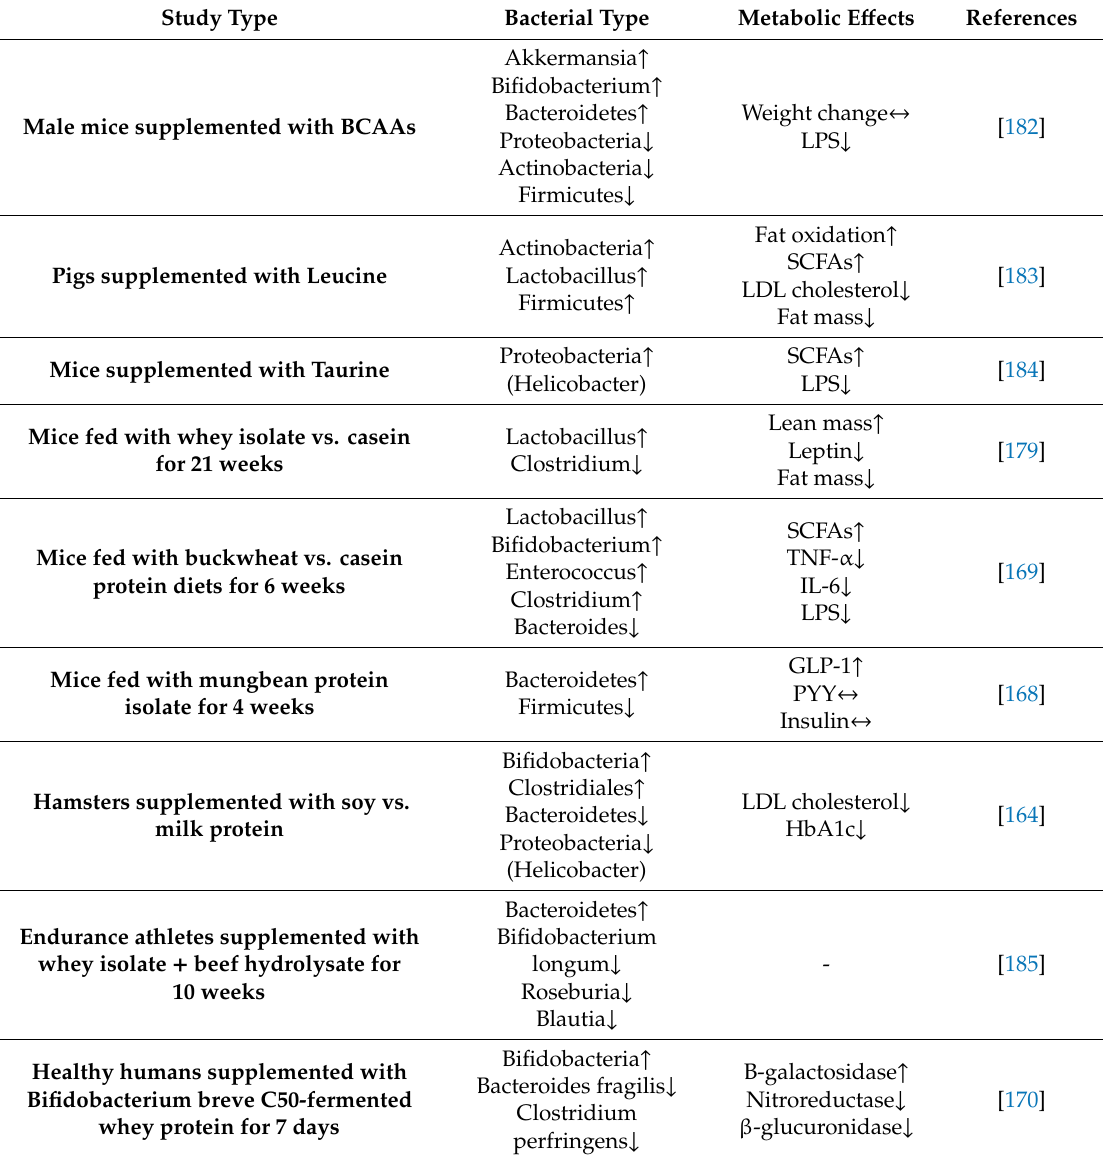
Table 1. Metabolic e ff ects of protein supplementation and gut microbiota interaction in selected animal and human